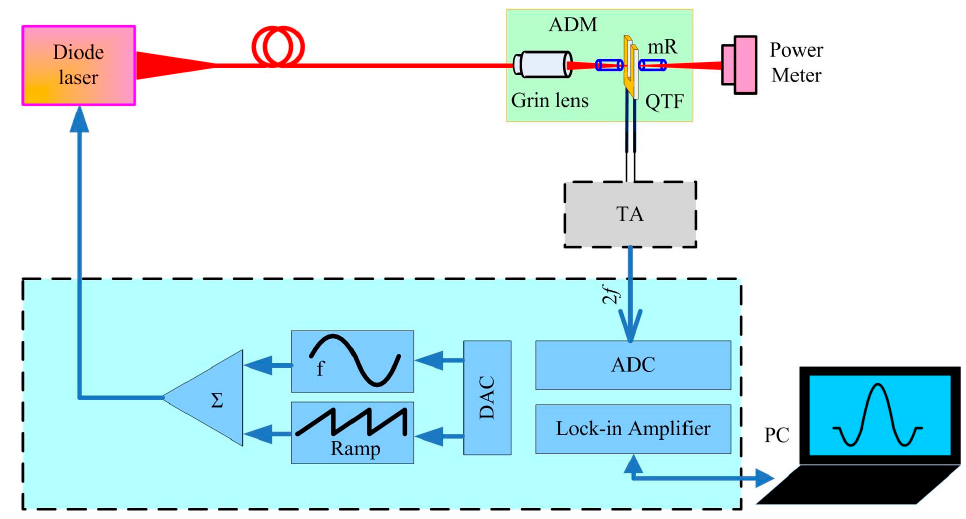
Figure 2. Schematic of the developed QEPAS sensor setup.